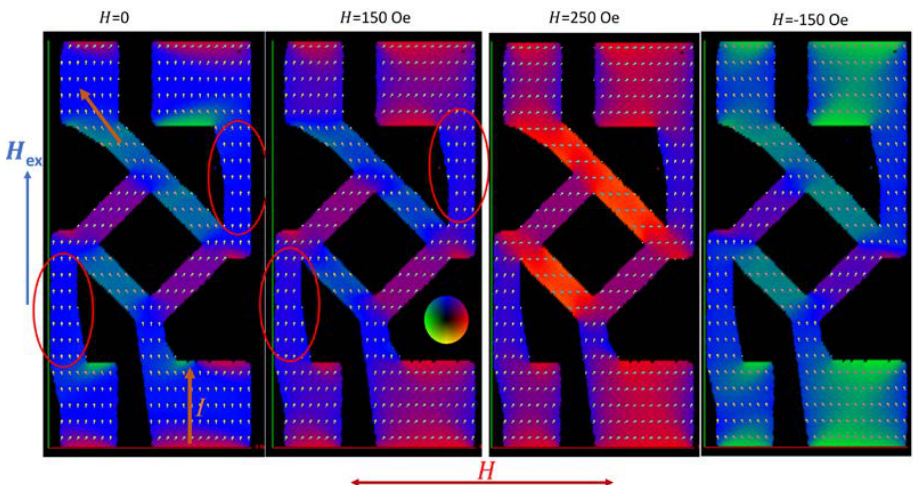
Figure 7. Simulated multi-domain magnetization distribution of the AMR bridge structure at different field values ( H = 0 Oe, H = -150 Oe, H = 150 Oe, H = 250 Oe). The red arrow signifies the direction of the applied field while the blue arrow shows the orientation of the exchange bias field. The encircled areas show that no matter the field value, the orientation of the magnetic moments does not change and does not influence the behavior of the central area of the structure, thus there is no signal change with the applied field for these areas.